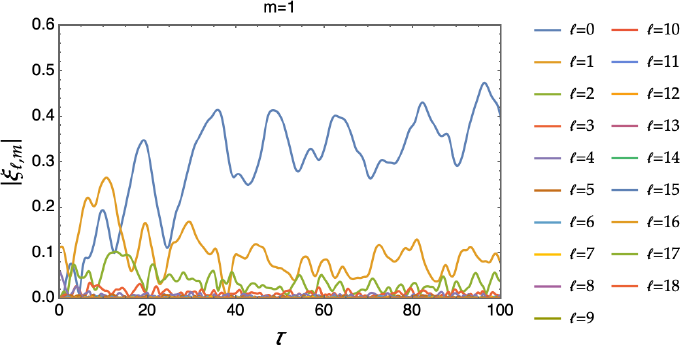
Figure 7. Case A2—inviscid. Evolution of | ξ (cid:96) ,1 | with (cid:96) (cid:62) 0 for small temporal scales to highlight the mode saturation.